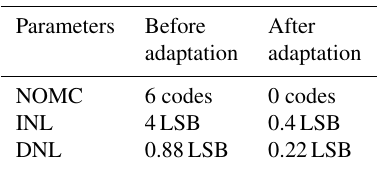
Table 4. The parameter values of SN-ADC before and after adap- tation.